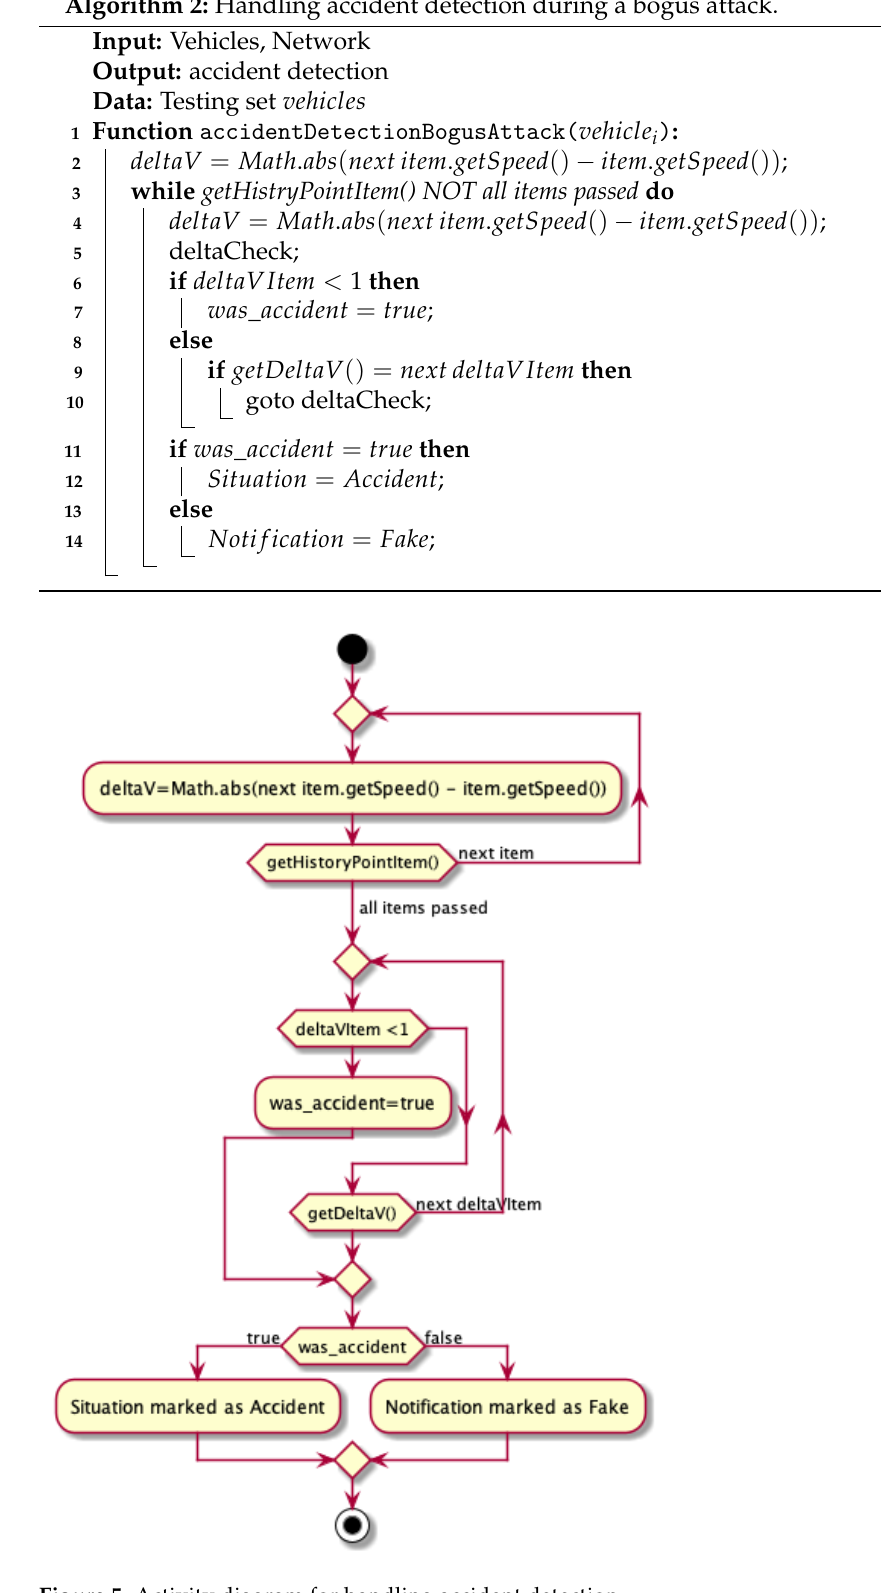
Figure 5. Activity diagram for handling accident